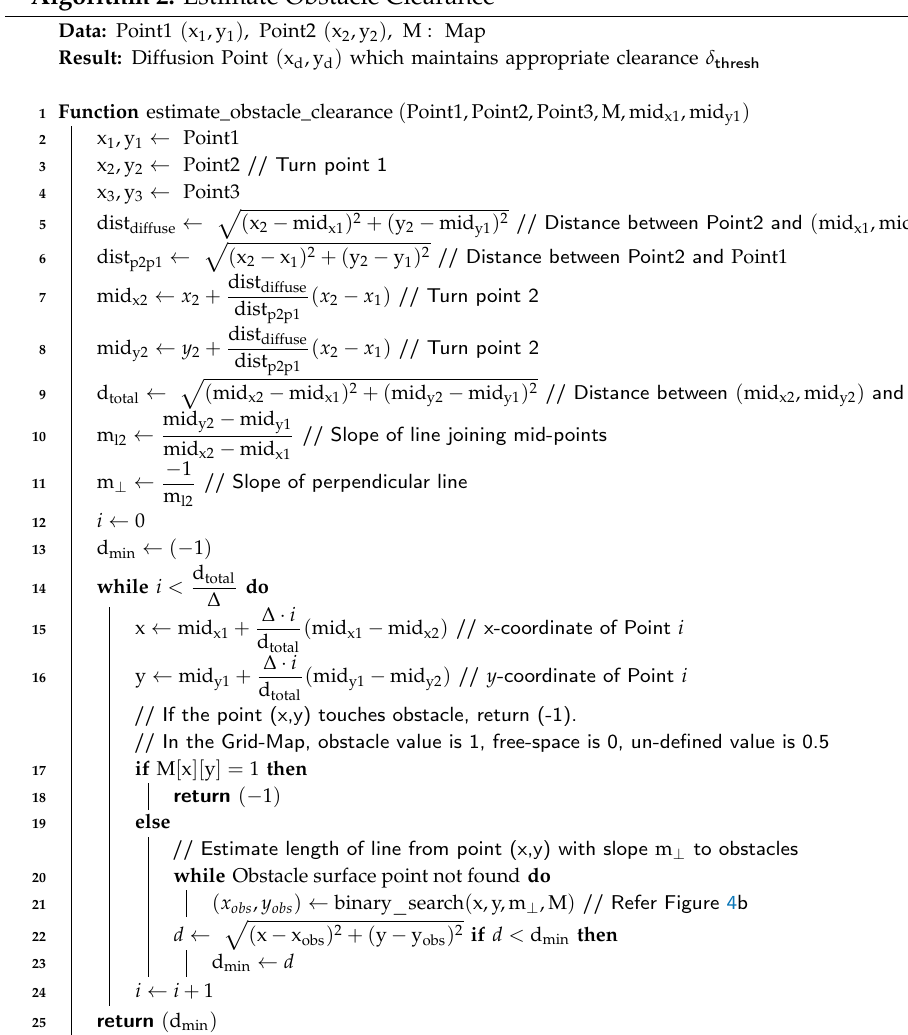
Algorithm 2: Estimate Obstacle